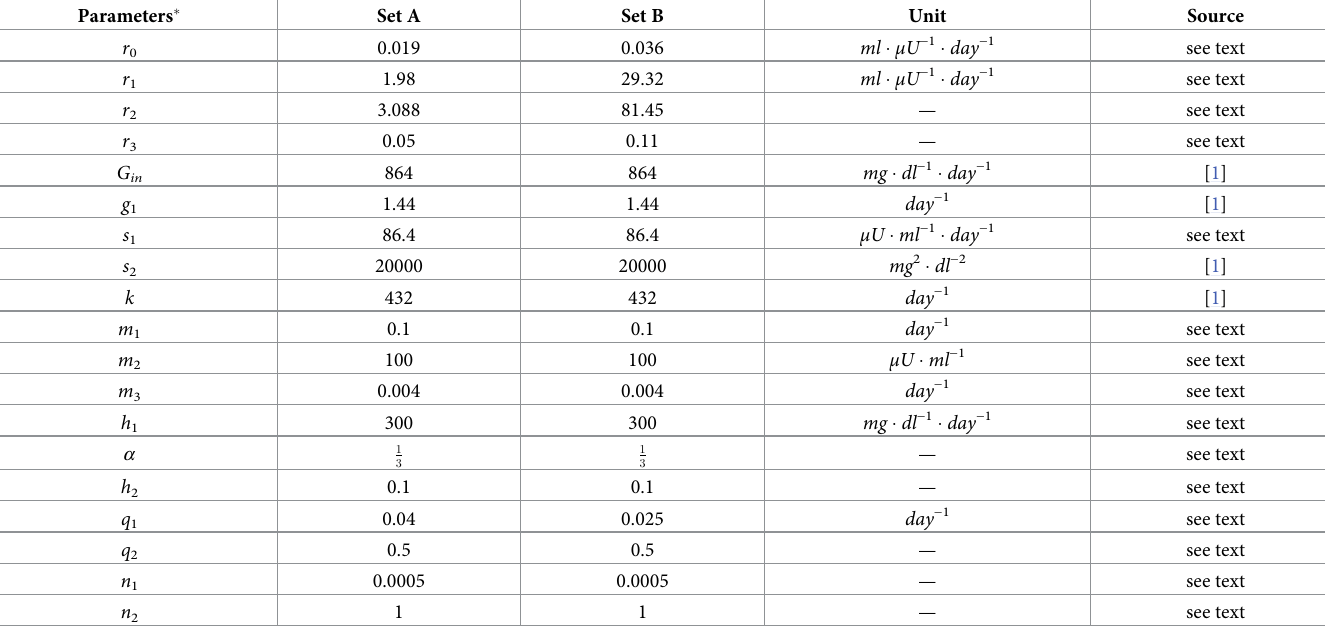
Table 1. Parameter values for the undisturbed glucose-insulin regulatory model and obesity-related diabetes model. Parameters